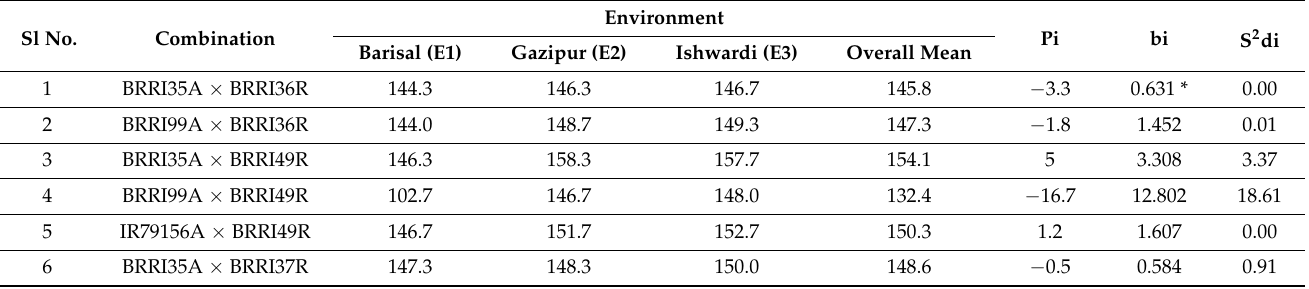
Table 4. Stability analysis for days to maturity of 26 hybrid combinations at three